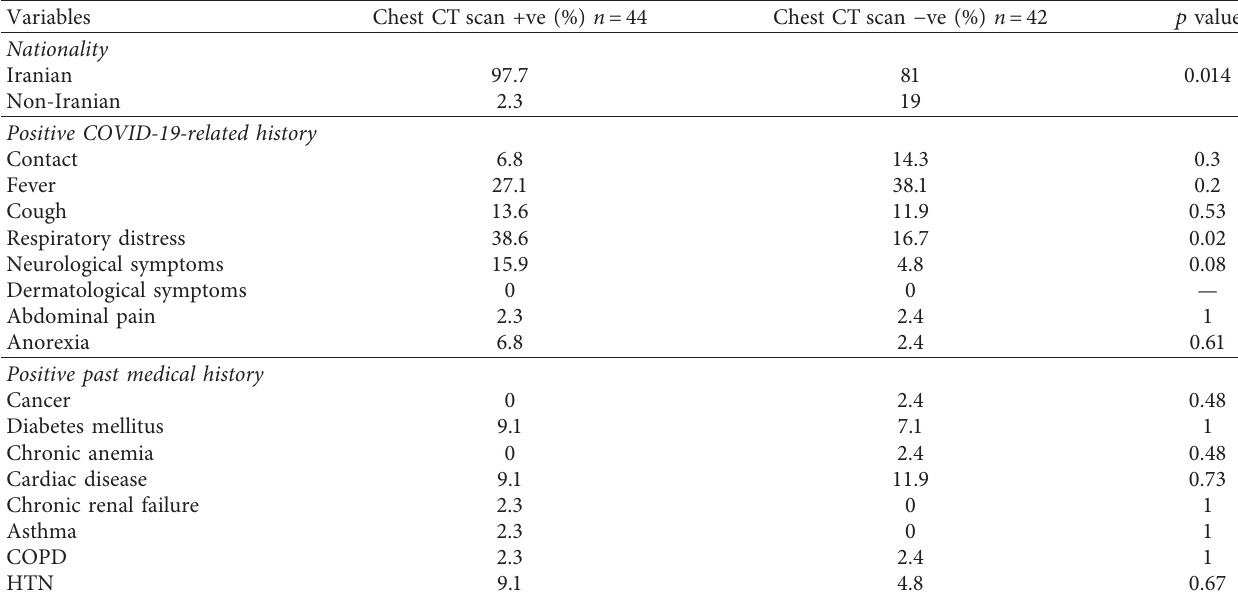
Table 2: Comparison of COVID-19-related criteria between positive and negative CT scan groups.